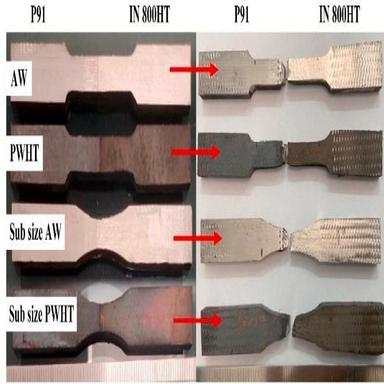
Prepared tensile specimens and fractured tensile specimens after testing.